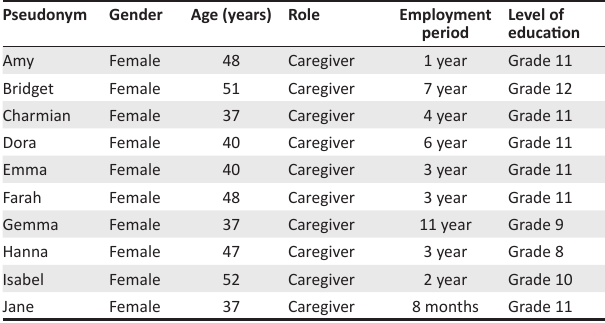
TABLE 1: Demographic information of